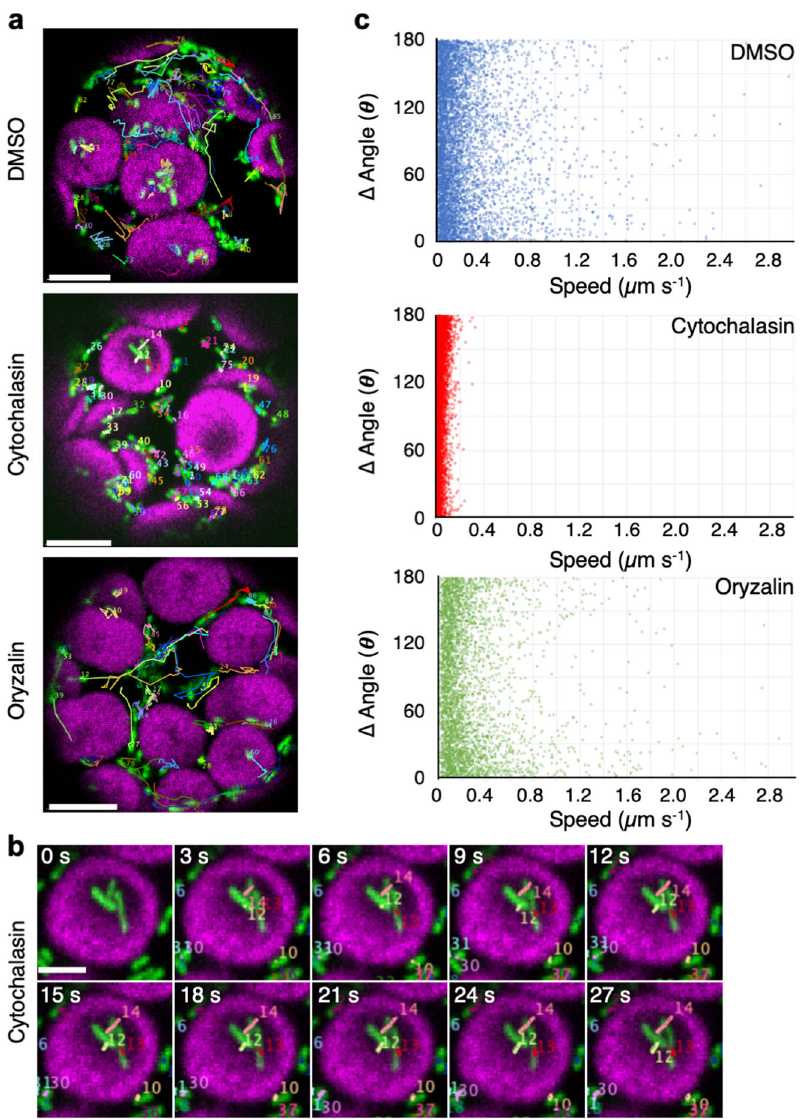
Fig. 4 Characterization of mitochondrial movement in the presence of cytoskeletal inhibitors. a Trajectories of mitochondrial movements in DMSO-, cytochalasin B (cytochalasin)-, and oryzalin-treated protoplasts acquired from time-lapse analysis of images taken for 30 s at 250-ms intervals. Scale bar; 5 µ m. b Time-lapse images of mitochondria on the chloroplast surface in cytochalasin-treated protoplasts at 3-s intervals. Scale bar: 2 µ m. c Scatter plot of speed ( x -axis) and angle changes ( y -axis) of mitochondria at each time point acquired from the trajectories of mitochondrial movements in a . Protoplasts treated with DMSO (blue open circles), cytochalasin (red open circles), and oryzalin (green open